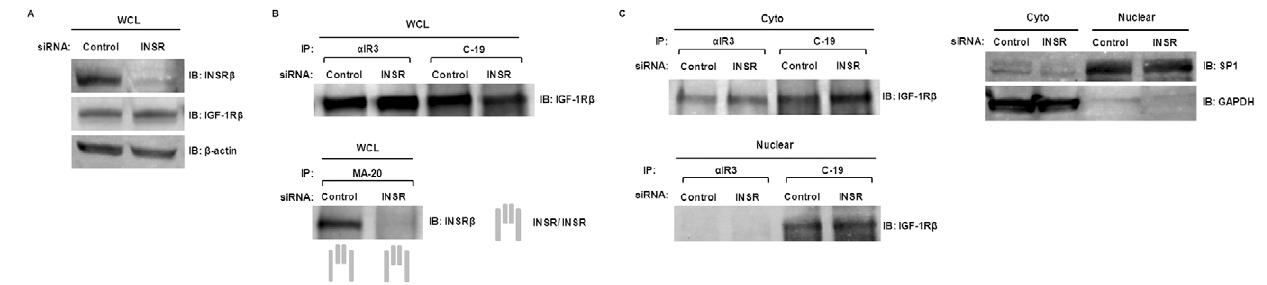
Figure 7. Knockdown of IGF-1R/INSR. Control or INSR siRNA were transfected into hTCEpi cells. Two to three days after transfection, WCL, cytosolic (Cyto) and nuclear fractions (Nuclear) were collected. (A) Immunoblots of WCL with antibodies against INSR (C-19), IGF-1R (CST # 3027), or b - actin (loading control). (B) WCL of hTCEpi cells were immunoprecipitated with antibodies a IR3, C-19, or MA-20 (against INSR a and only reacts with INSR/INSR). Immunoprecipitates were then immunoblotted with anti-IGF-1R b (CST # 3027) or anti-INSR b (C-19). (C) Cytosolic and nuclear fractions of hTCEpi cells were subjected to immunoprecipitation with antibodies a IR3 or C-19. Immunoprecipitates were then immunoblotted with anti-IGF-1R b (CST # 3027). GAPDH is the marker for cytosolic extract; and SP1 is the marker for nuclear extract.